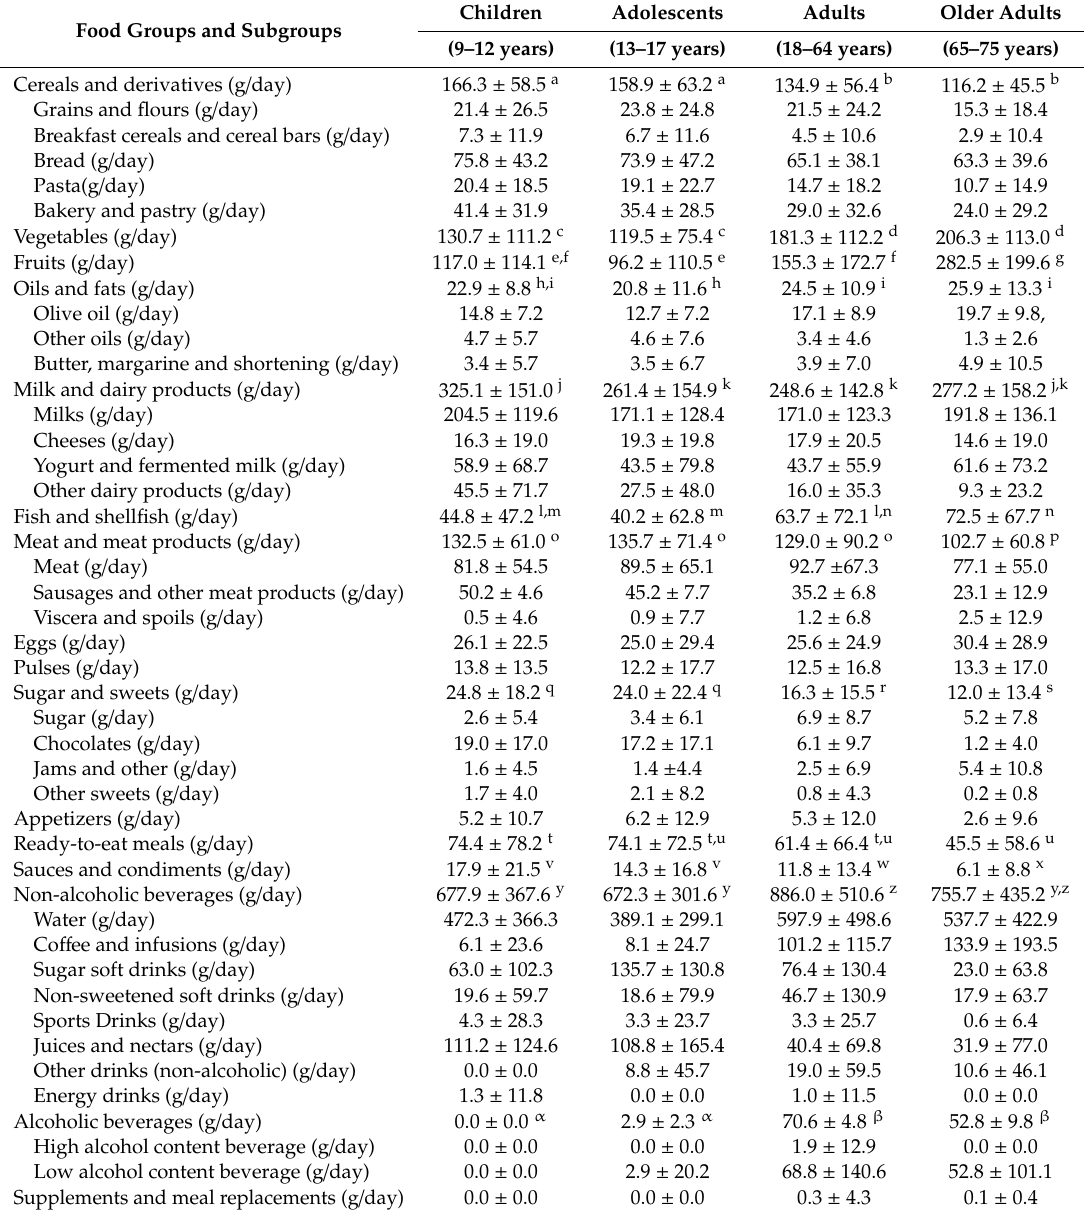
Table 5. Total daily food groups and subgroups intake by age in the female Spanish ANIBES study